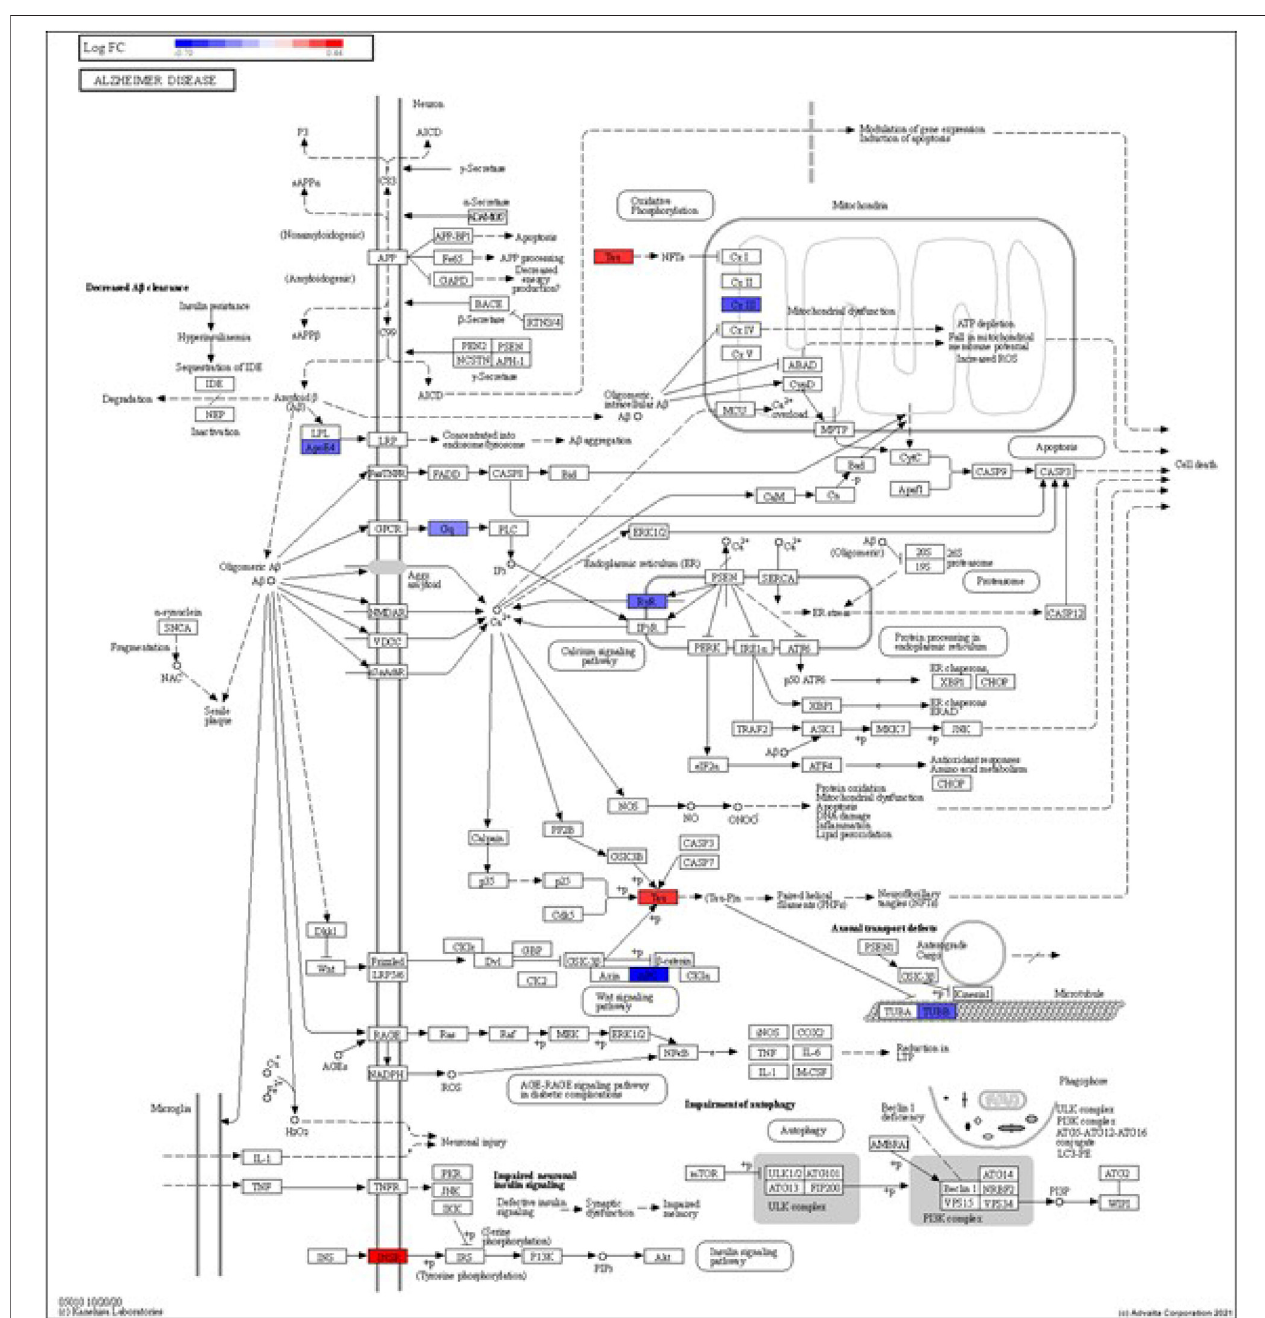
FIGURE4| iPathwayGuideanalysisshowsthedifferentiallyregulatedgenesintheKEGGAlzheimer ’ sdiseasepathwayinastrocytesfromtheADgroup(AD00205) compared to astrocytes from the healthy control group (AD00201).